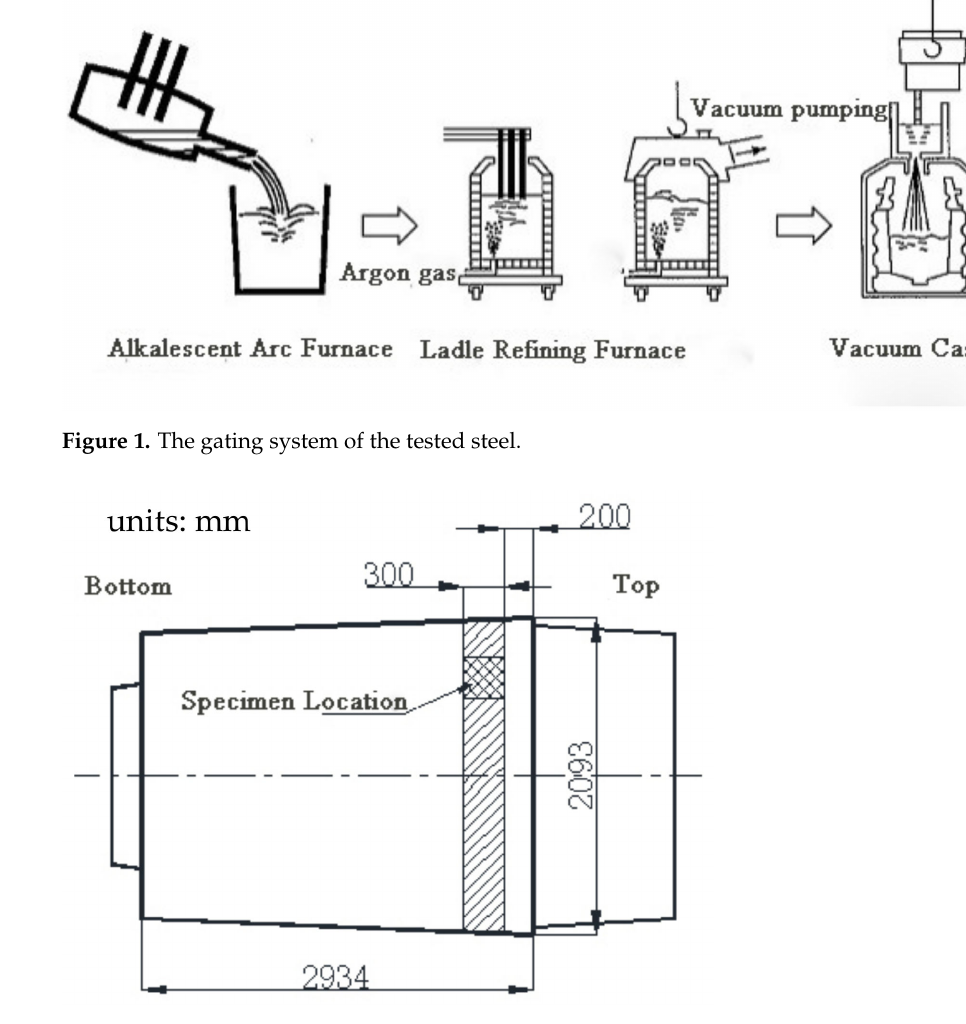
Figure 2. The position of the compressed tested